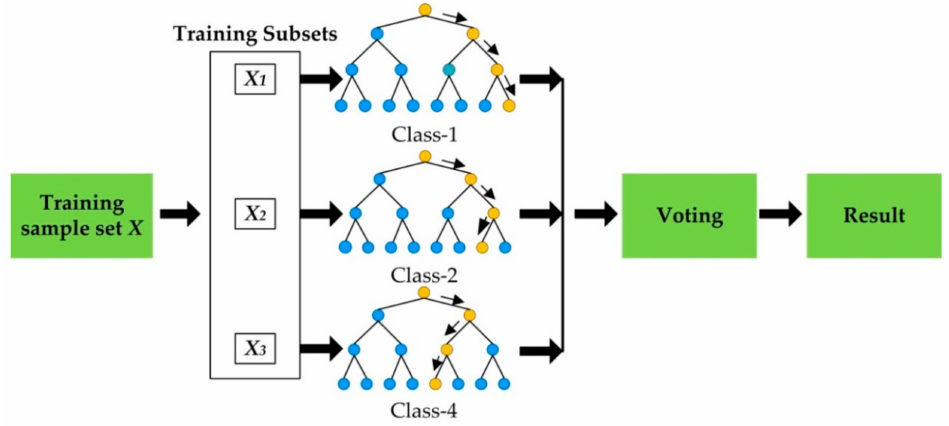
Figure 1. The process of producing Random Forest (RF)